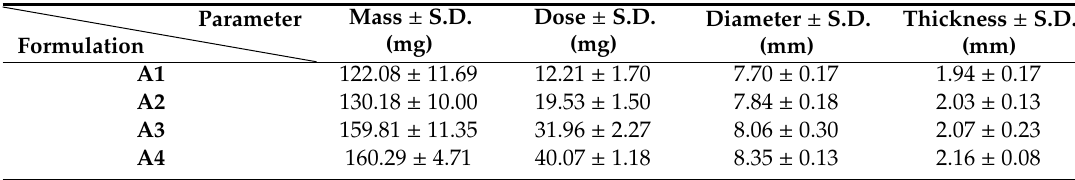
Table 6. Mass, dose and dimensions of the tablets (mean ±